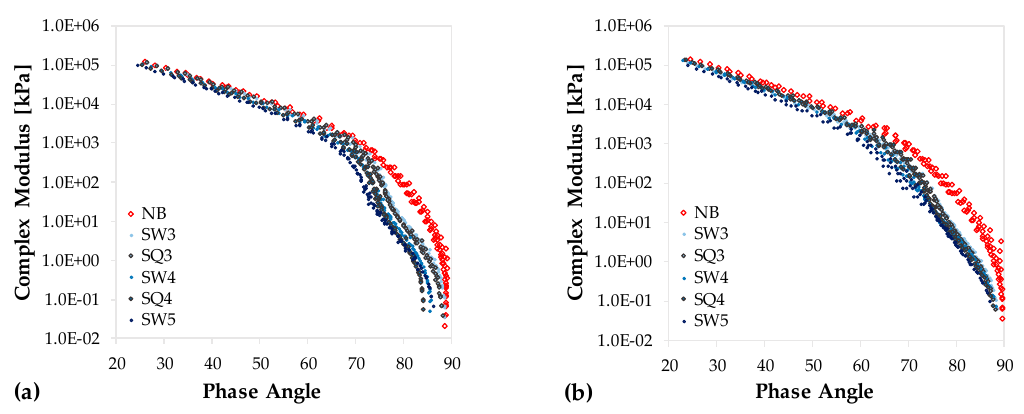
Figure 6. Black diagrams of SBR-modified binders: ( a ) unaged binders; ( b ) RTFO-aged binders.